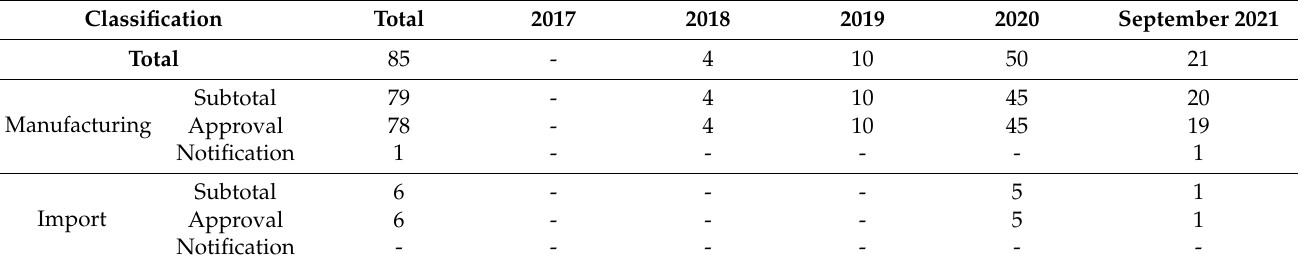
Table 3. Approval status of AIMDs in the Republic of Korea.